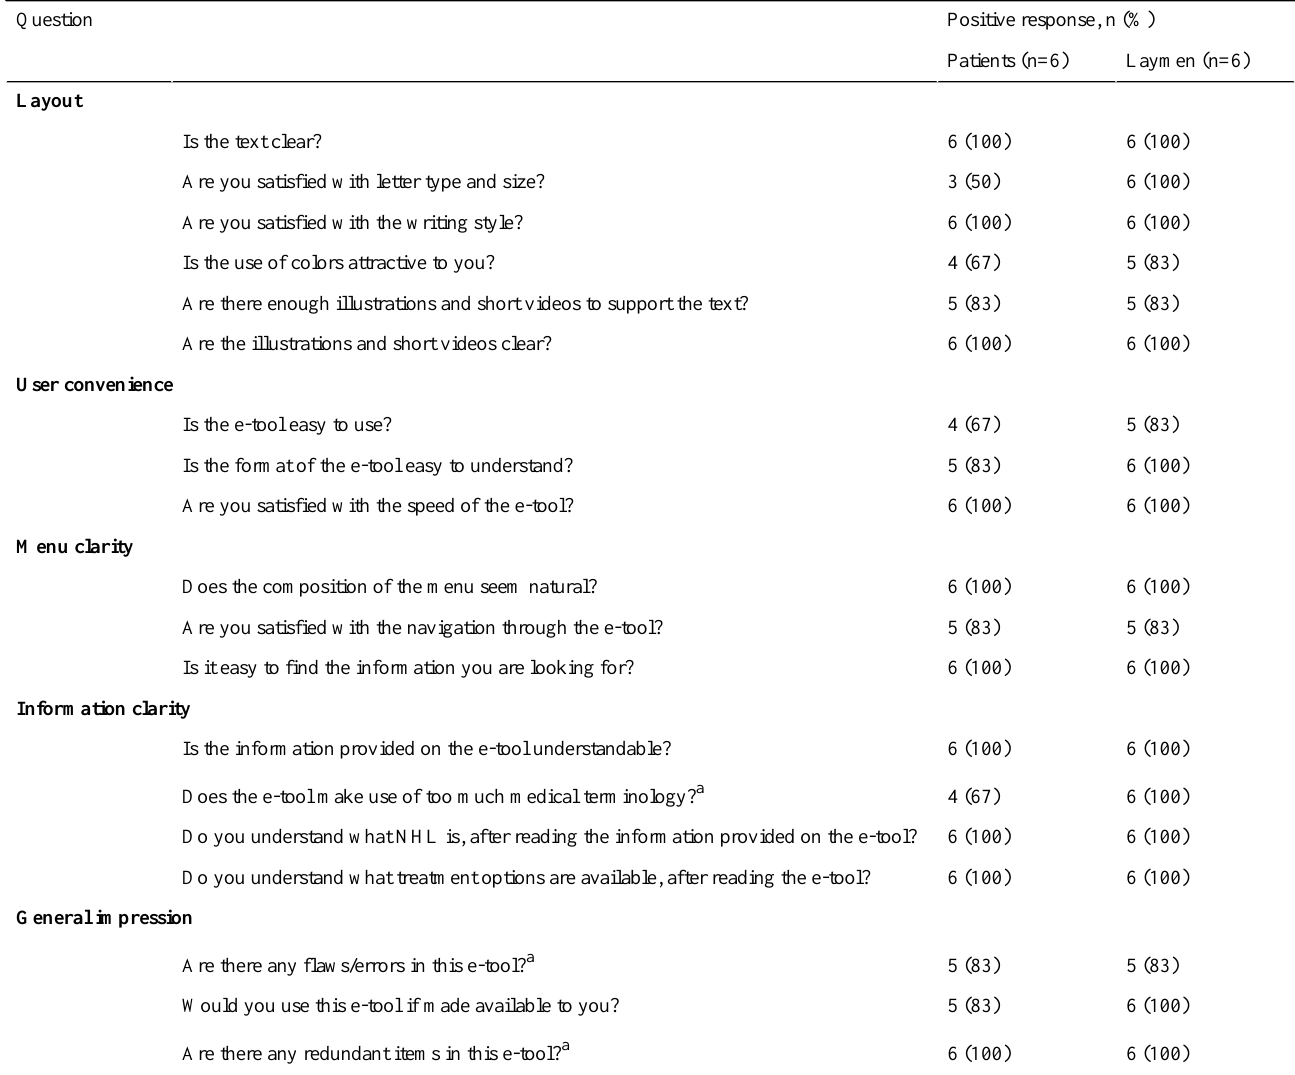
Table 1. Results of the e-tool evaluation among NHL patients and laymen (closed